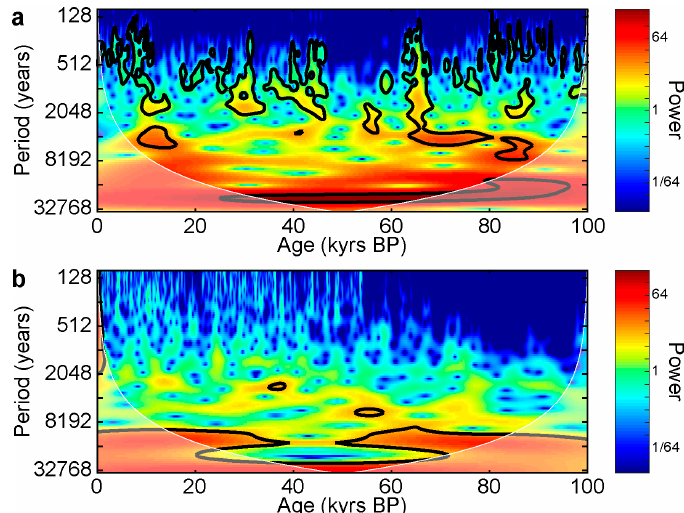
Figure 5. Wavelet analyses of the BT2 and Western Amazonia (WA) δ 18 O time series. ( a ) Wavelet analysis of the BT2 δ 18 O time series using a wavelet toolbox for MATLAB® [41] . Prior to the wavelet analysis, the unequally distributed δ 18 O time series is transformed to an equally distributed (50 years) time series using a Gaussian kernel [42] . The white shaded area indicates the cone of influence, whereas the black envelopes frame statistically significant periods. (b) Same as panel ( a ) but for the WA δ 18 O time series. The WA δ 18 O time series follows, with exception of the period from 70 kyrs BP to 20 kyrs BP, austral summer insolation, and is thereby also broadly in-phase with the BT2 δ 18 O time series (Figure 4 a,b). This is also evident by the wavelet analysis of the WA δ 18 O time series (Figure 5b). Marked differences between the δ 18 O time series from southeast Brazil and western Amazonia occur from 70 kyrs BP to 20 kyrs BP when the two time series appear to be anti-correlated and when the precession signal is absent in the WA δ 18 O time series (Figure 5b). That is, when the BT2 δ 18 O time series decreases, indicating wetter conditions in southeast Brazil, the WA speleothem δ 18 O values increase, inferring drier conditions in western Amazonia. This change in the phase-relationship between BT2 and the WA speleothems is also observed between the WA δ 18 O time series and the austral summer insolation (Figure 4b and 5b). The coherence of orbital-scale changes between southeast Brazil and western Amazonia speleothem δ 18 O time series from ~120 kyrs BP to 60 kyrs BP and from ~20 kyrs BP to the present indicates that SAMS rainfall variability broadly co-varies between these spatially